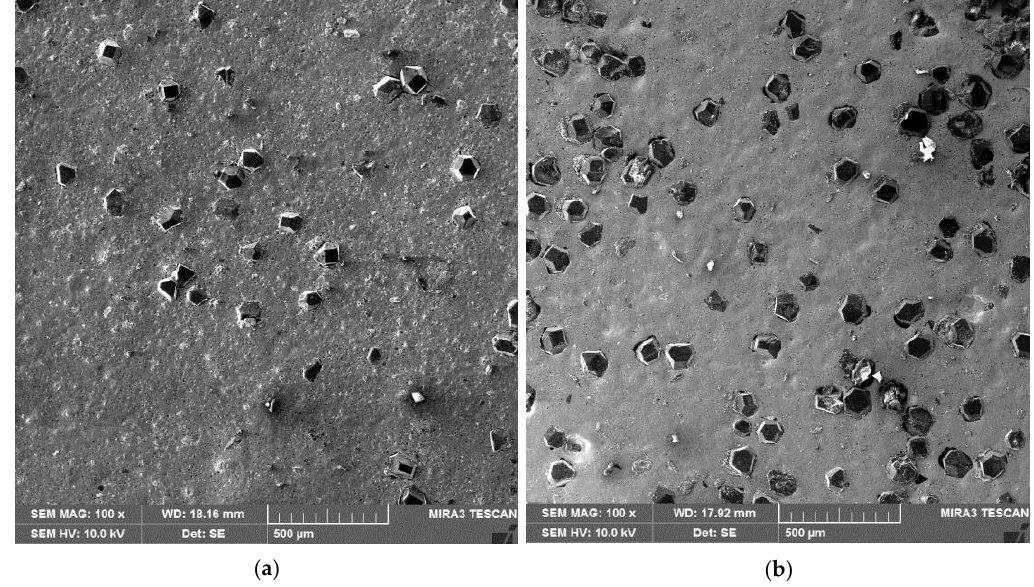
Figure 2. SEM images of the Cu/CrD composite with diamond fractions—( a ) 5 vol %; ( b ) 20 vol %.